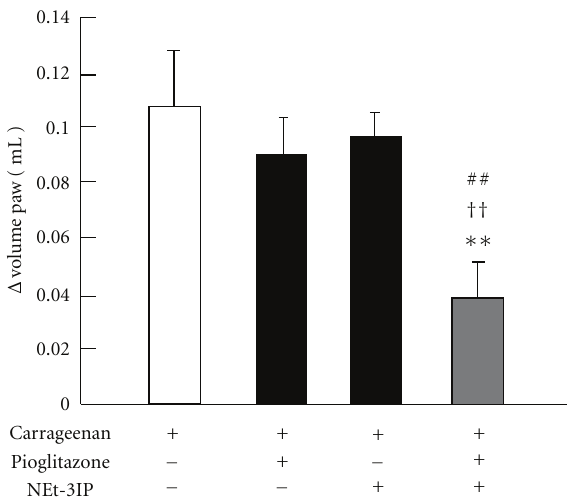
Figure 4: Influence of PPAR antagonists on RXR agonist and PPAR γ agonist-induced anti-inflammatory e ff ects . NEt-3IP was orally administrated 3 h before carrageenan injection at a dose of 10 mg/kg. Nonselective PPAR antagonist, BADGE was injected intraperitoneal 30 min before carrageenan injection at doses of 10 and 30 mg/kg. PPAR α antagonist, GW6471 was injected into subplantar 15min before carrageenan injection at doses of 10 and 30 μ g/paw. PPAR γ antagonist, GW9662 was injected into subplantar 15min before carrageenan injection at doses of 3 and 10 μ g/paw. PPAR δ antagonist, JKPL-85 was injected into subplantar 15min before carrageenan injection at doses of 10 and 30 μ g/paw. The vehicle group received physiological saline including 10% dimethylsulphoxide. Each column and vertical bar represents the means ± S.E.M. ( n = 7). ∗∗ : Significantly di ff erent from the control group at P < 0 . 01 (Dunnett’s test). † , †† : Significantly di ff erent from the vehicle group at P < 0 . 05 and P < 0 . 01, respectively (Dunnett’s test).